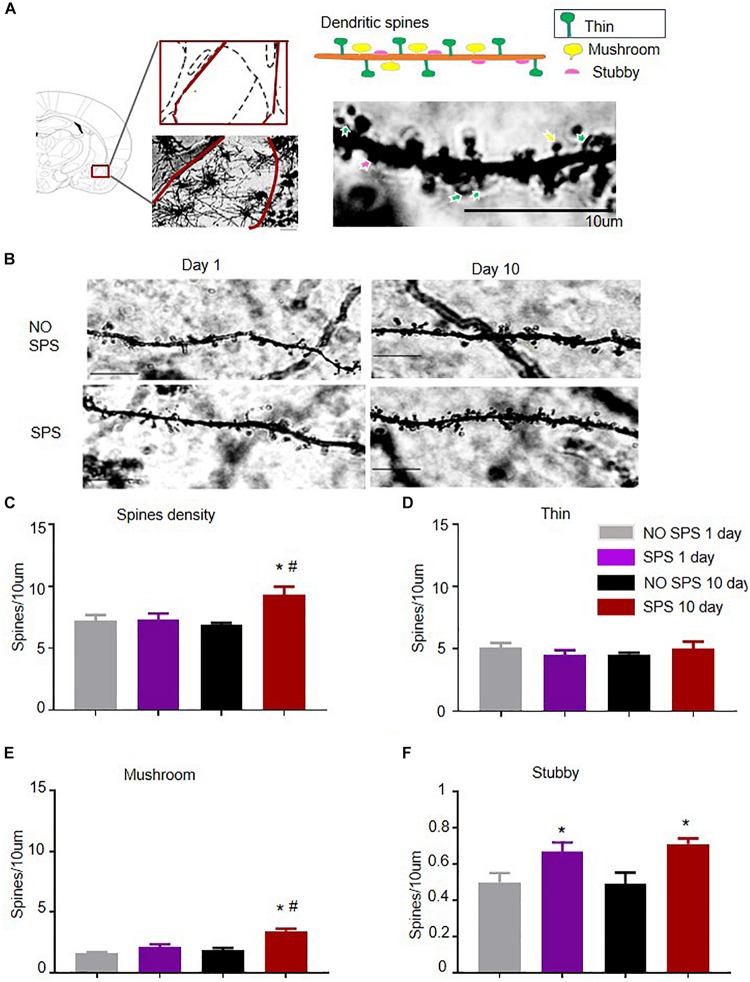
Effect of SPS paradigms on spine density of BLA pyramidal neurons. (A) Low-power image of dendritic spines of BLA from control rats. Scale bar = 10 μm. Dendritic spines were classified based on morphology: thin dendritic spines have thin head and long neck (indicated by green arrows), mushroom dendritic spines come with large head and short neck (indicated by yellow arrows) and stubby dendritic spines have large head but no apparent neck (indicated by red arrows). Scale bar = 10 μm. (B) High-power image of representative dendrite segments (scale bar = 10 μm). (C) Spine density in BLA pyramidal dendrite segments in different experimental conditions (animals, rats = 5; segments, n = 5–8, total dendritic length = 40–70 μm). (D–F) Average density in mushroom (D), thin (E), and stubby (F) spines in BLA pyramidal dendrite segments sampled from four groups: NO SPS(1d)/SPS(1d)/NO SPS(10d)/SPS(10d). #Different from SPS(1d) group, #*Different from NO SPS group at each post-SPS day, #*p < 0.05, two-way ANOVA. Data are shown as means ± SEM.